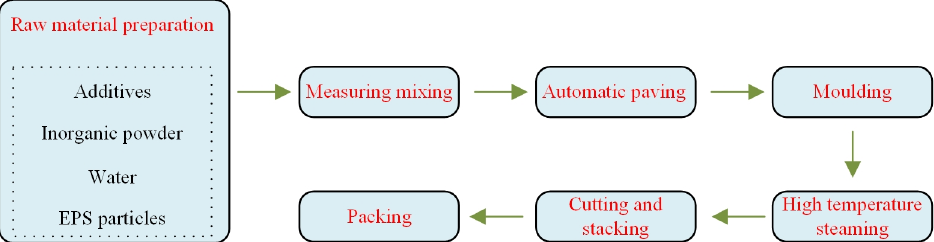
Figure 8. The A-class insulation board technological process.